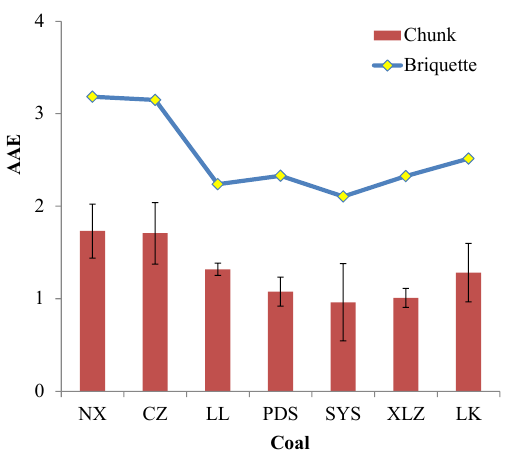
Figure 5. Comparison of AAEs (absorption Ångström exponents) between briquette and chunk coals.